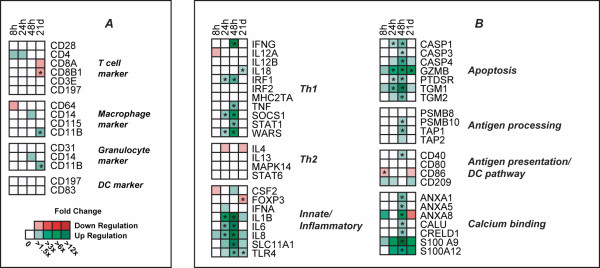
Transcriptional profile of selected cell-type marker and immune response pathway genes by Affymetrix DNA microarray analysis. Expression patterns of specific marker genes for T cell, macrophage, granulocyte and dendritic cell types (A) or important immune response pathways (B) are shown. The fold change from comparisons of infected pigs and non-infected controls at each time point were calculated from the Affymetrix array data using Genecluster. Statistical differences (p < 0.05) between control and infected pigs are represented by an asterisk (*).